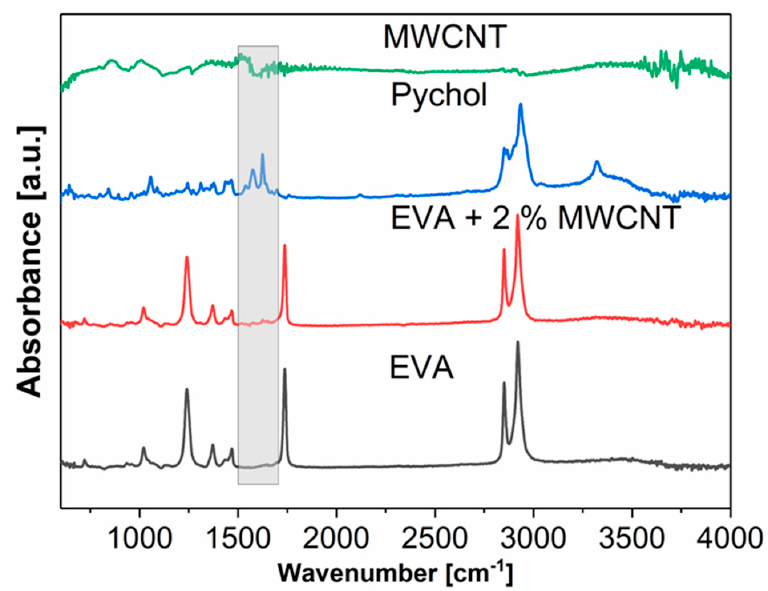
Figure 5. Comparison of the Fourier transform infrared spectroscopy (FTIR) spectra of EVA, the compatibilizer cholesteryl 1-pyrenecarboxylate (PyChol), MWCNTs, and EVA/2.0 wt % MWCNTs.